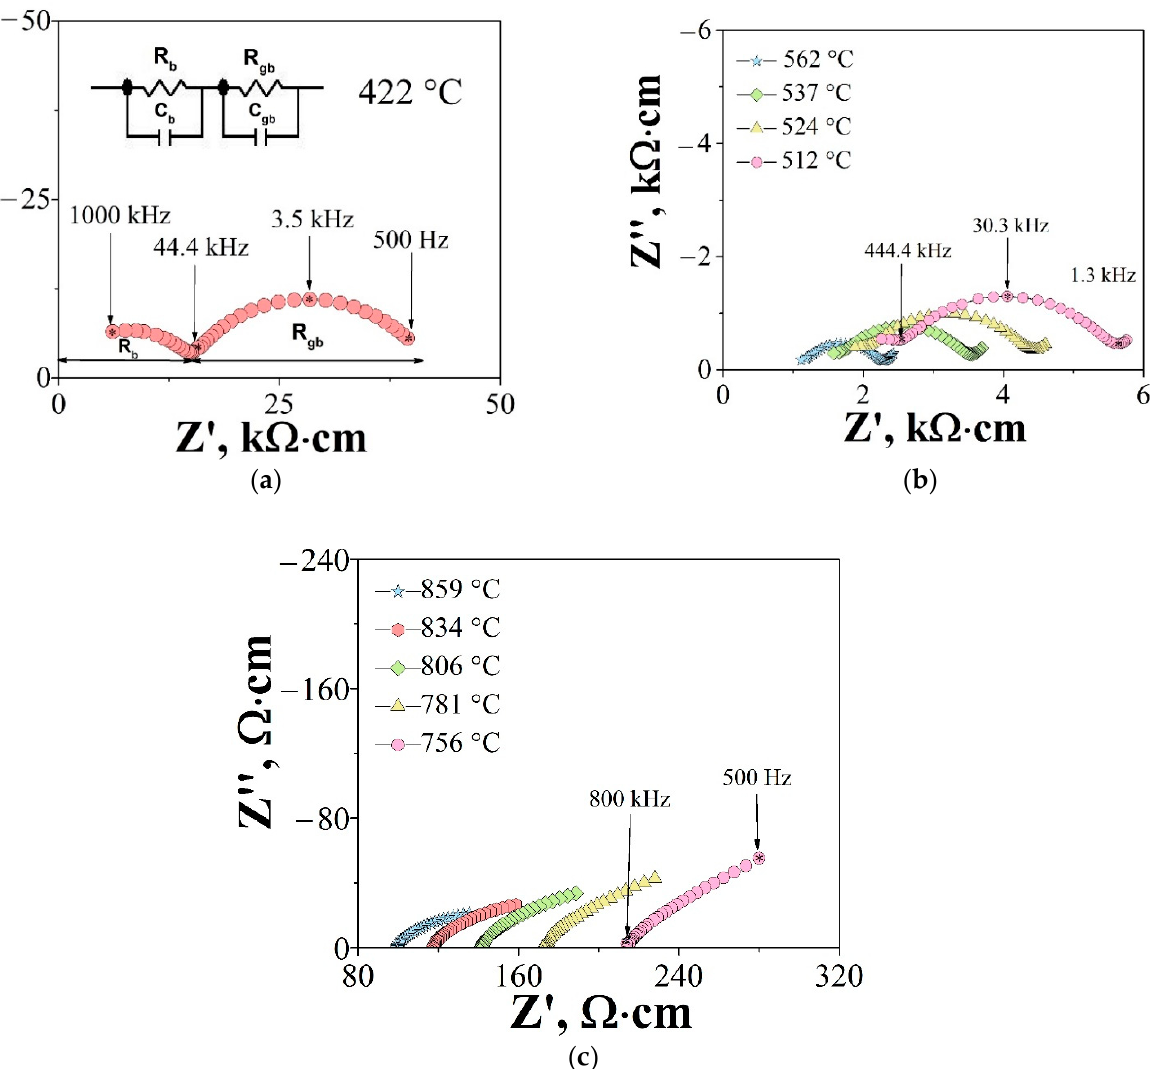
Figure 5. Typical ac impedance plot recorded at 422 °C as representation in the form of the Nyquist plot and corresponding equivalent circuit for Gd 1.97 Mg 0.03 Zr 2 O 6.98 ( a ), at 512–562 o C ( b ), at 756–859 °C ( c ) in air. R b , R gb , CPE b , and CPE gb represent bulk resistance, grain-boundary resistance, constant phase element of the bulk and constant phase element of the grain-boundary. Selected frequencies are indicated by arrows.